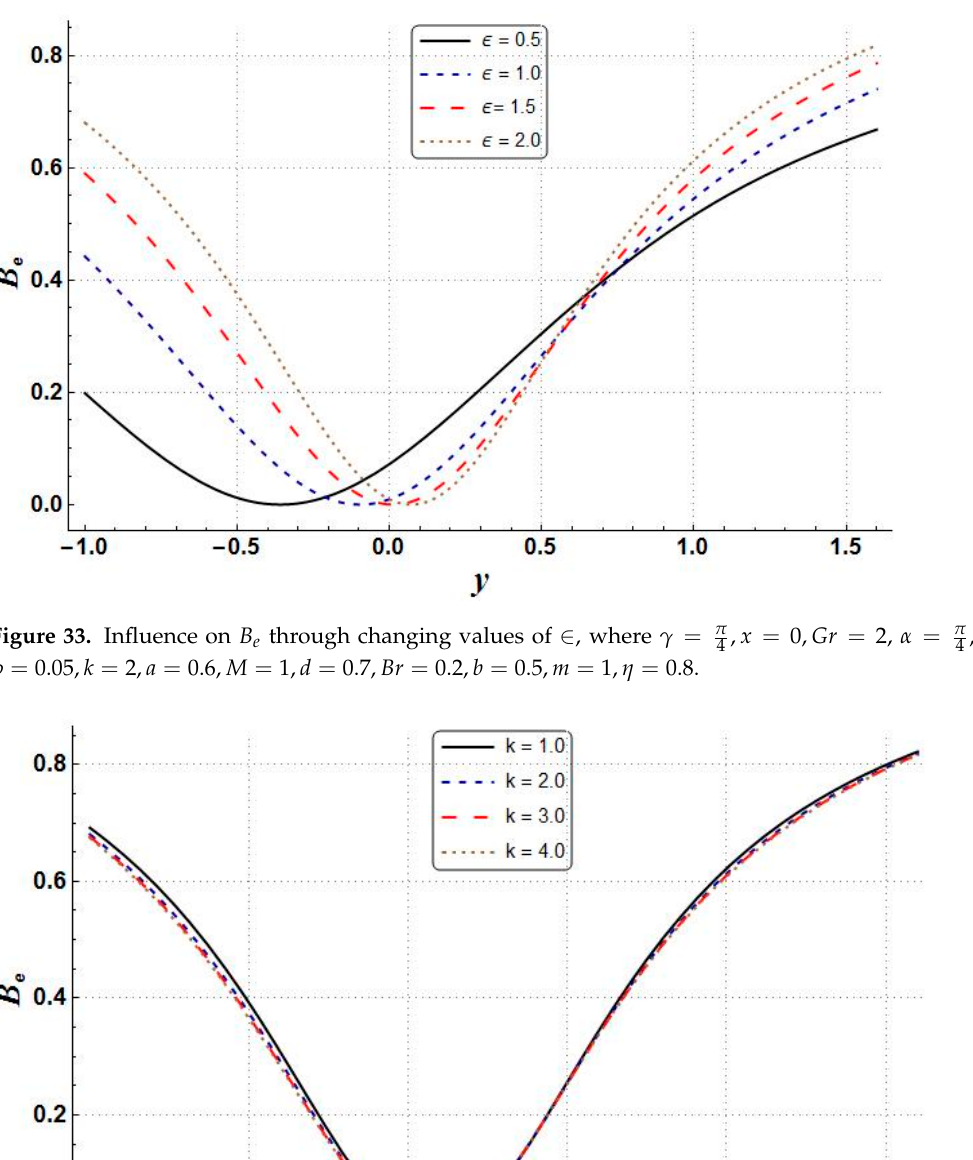
B through changing values of